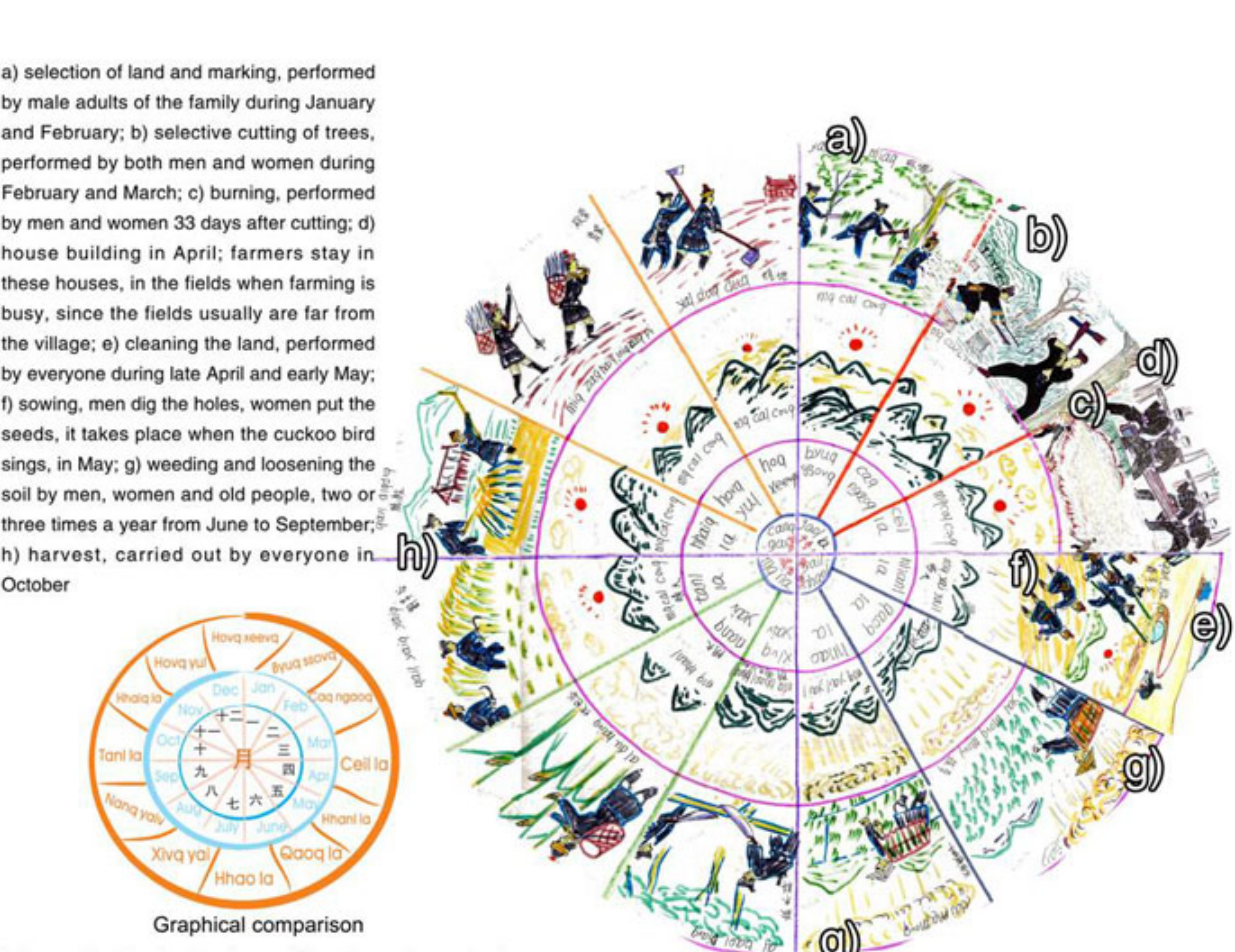
Figure 6. The swidden agricultural calendar of the Hani community in Mensong, as illustrated by a local